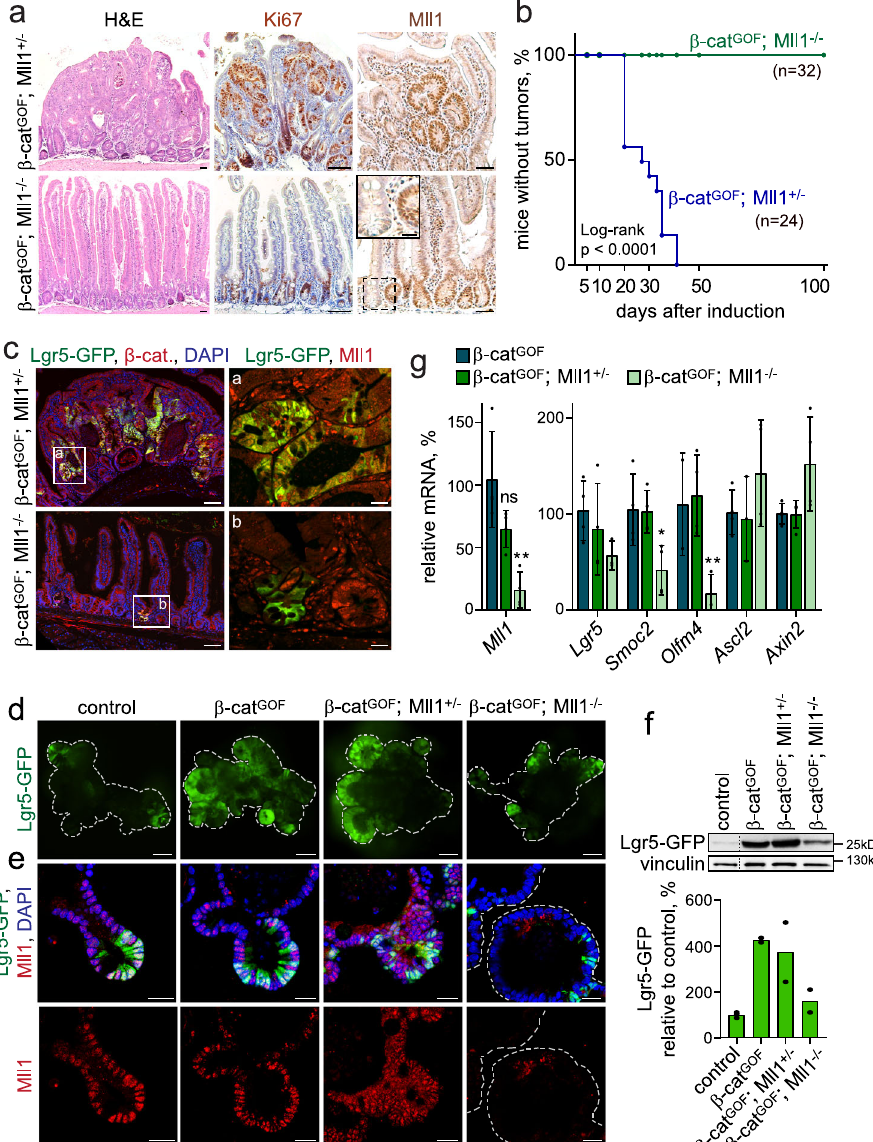
Fig. 2 The β -catenin GOF -induced intestinal stem cell expansion and tumorigenesis depend on Mll1. a Sections of intestines of Lgr5-EGFP-IRES-Cre ERT2 ; β -cat GOF ; Mll1 + / − and Lgr5-EGFP-IRES-Cre ERT2 ; β -cat GOF ; Mll1 − / − mice, called β -cat GOF ; Mll1 + / − and β -cat GOF ; Mll1 − / − , at 30 days after induction with tamoxifen: H&E staining (left), scale bar 50 µ m; Ki67 staining (middle), nuclei counterstained with hematoxylin, scale bar 100 µ m; Mll1 immunohistochemistry (right), scale bar 50 µ m, with the magni fi cation of Mll1 knockout crypt in inset, scale bar 20 µ m. Stainings were performed on sections of three independent mice per genotype. b Kaplan – Meier plot of tumor incidence in β -cat GOF ; Mll1 + / − and β -cat GOF ; Mll1 − / − mice. c Immuno fl uorescence for Lgr5-GFP stem cells (green) and β -catenin (red) on intestinal sections of β -cat GOF ; Mll1 + / − and β -cat GOF ; Mll1 − / − mice at day 30 after induction, scale bar 100 µ m. Insets a , b immunostaining for Lgr5-GFP (green) and Mll1 (red) on serial sections, scale bar 20 µ m. Stainings were performed on sections of three independent mice. d Fluorescence live imaging of non-induced (control) and tamoxifen-induced Lgr5-GFP-IRES-Cre ERT2 ; β - cat GOF , Lgr5-GFP-IRES-Cre ERT2 ; β -cat GOF ; Mll1 + / − and Lgr5-GFP-IRES-Cre ERT2 ; β -cat GOF ; Mll1 − / − mouse intestinal organoids. Lgr5-GFP (green) marks intestinal stem cells, scale bars 100 µ m. Representative images from three independent experiments with three biologically independent organoid lines. e Immuno fl uorescence staining for Lgr5-GFP (green) and Mll1 (red) on sections of organoids of the four genotypes, nuclei in blue (DAPI), scale bars 30 µ m. Representative stainings from three independent experiments. f Western blot for Lgr5-GFP in control and tamoxifen-induced β -cat GOF , β -cat GOF ; Mll1 + / − , and β -cat GOF ; Mll1 − / − organoids of mice, vinculin as a control for equal loading. Quanti fi cation of Lgr5-GFP protein levels in mutant organoids relative to controls below, n = 2 samples from two independent experiments processed in parallel for western blotting. g mRNA expression of Mll1 and intestinal stem cell genes in β -cat GOF ; Mll1 + / − and β -cat GOF ; Mll1 − / − mouse organoids relative to β -cat GOF organoids, n = 4 independent experiments, two-tailed unpaired t -test, Mll1 ** p = 0.005, Smoc2 * p = 0.032, Olfm4 ** p = 0.037. Data are presented as mean values ± SD. Source data are provided as a Source Data fi le.